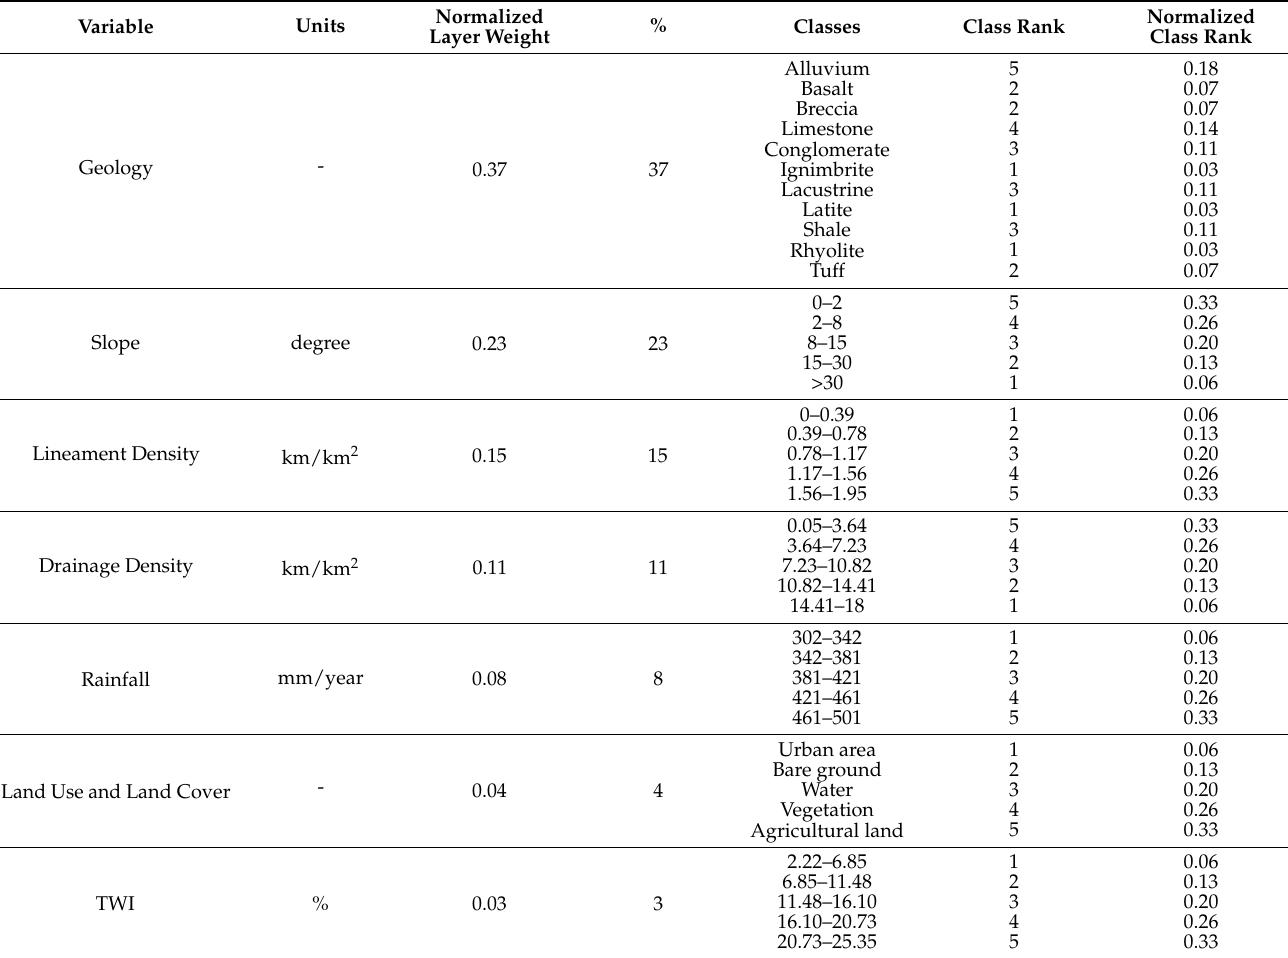
Table 5. Assigned normalized weights and ranks of thematic